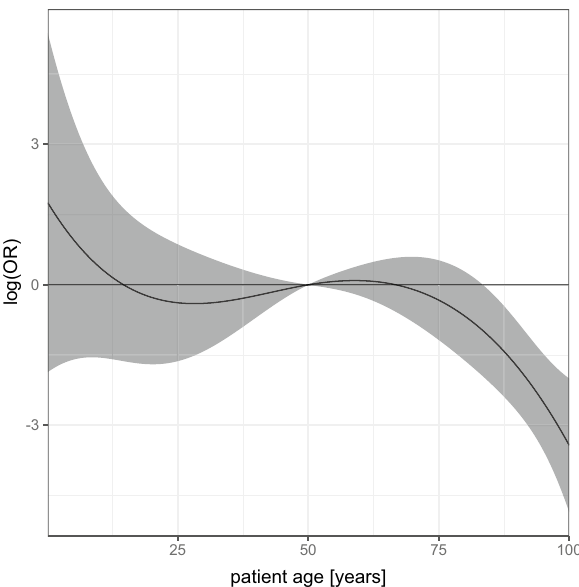
Figure 2. Graphic representation of odds ratios for patient age using cubic splines in main